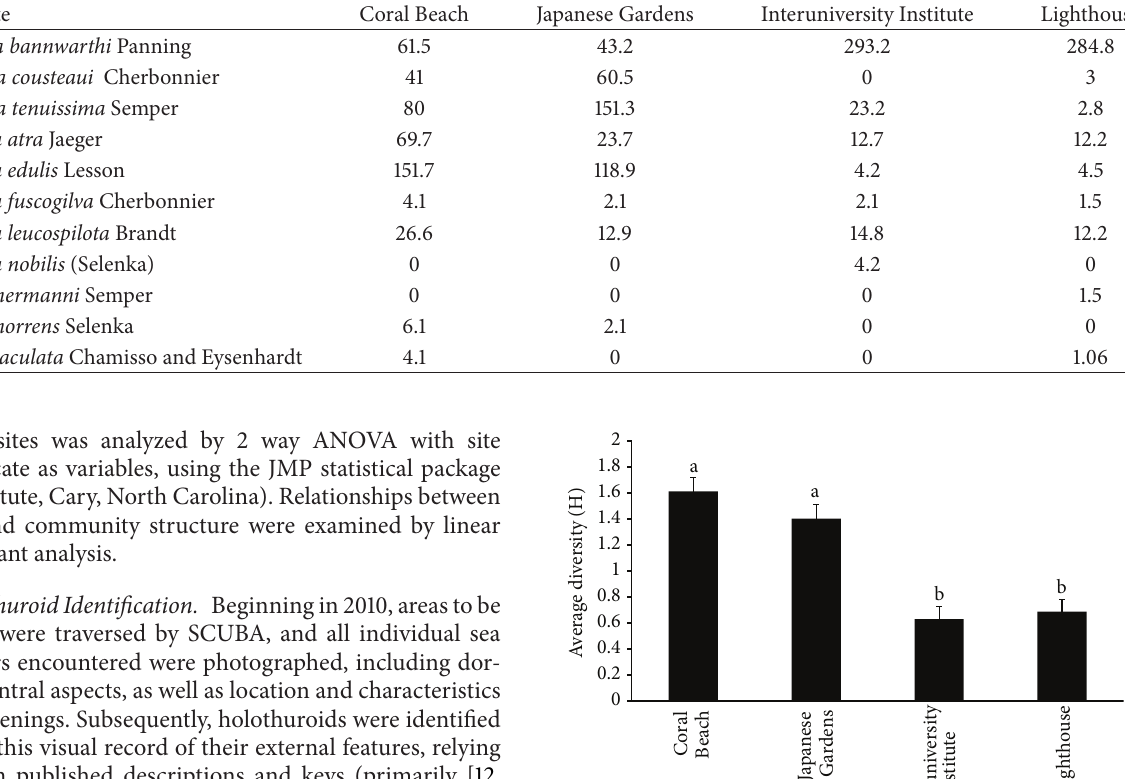
Table 1: Species of holothuroids observed and their density (extrapolated to individuals per hectare) at four shallow sites off the coast of Eilat, Red Sea.